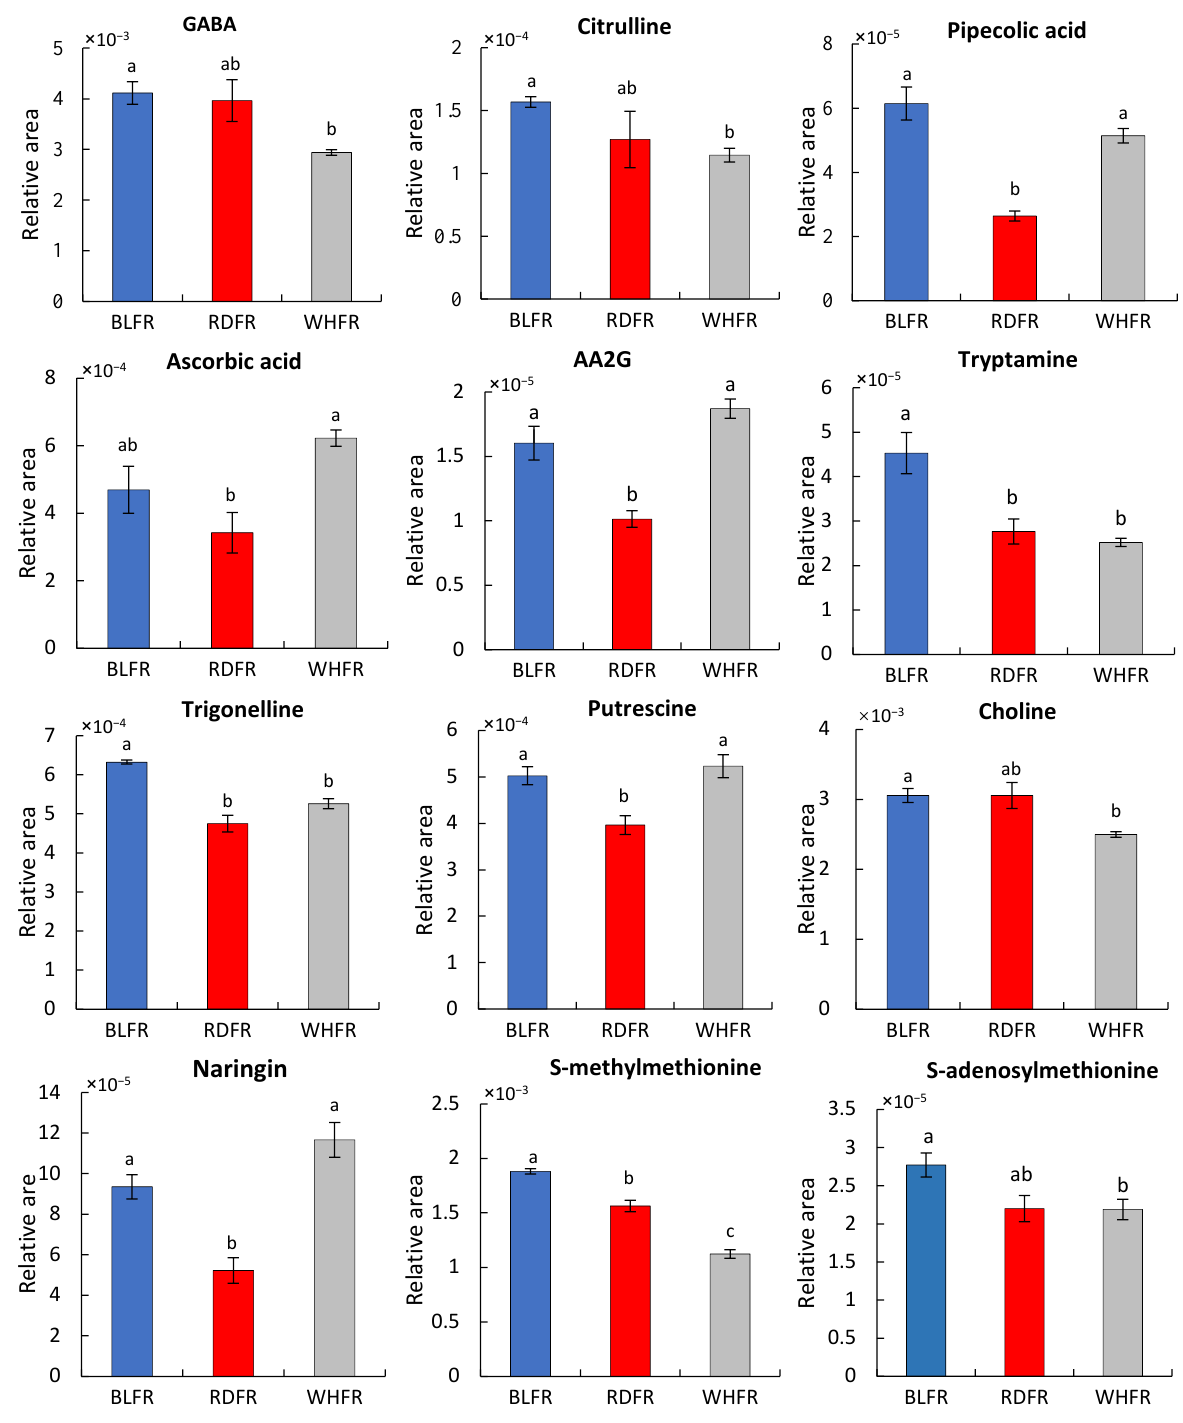
Figure 4. GABA, citrulline, pipecolic acid, ascorbic acid, AA2G, tryptamine, trigonelline, putrescine, choline, naringin, S-methylmethionine, and S-adenosylmethionine concentration in fruits treated with different lights. Values indicate the mean ± SE ( n = 3). Different letters indicate significant differences at p < 0.05 by Welch’s t -test. BLFR, RDFR, and WHFR refer to blue, red, and white light-treated fruits, respectively. In this study, the accumulation of two vitamins, ascorbic acid and tocopherol, in fruits was also influenced by light quality. Tocopherol concentration improved in BLFR. Α - Tocopherol showed higher levels in BLFR than RDFR, whereas γ -tocopherol showed higher levels in BLFR than WHFR (see Discussion). However, ascorbic acid showed lower